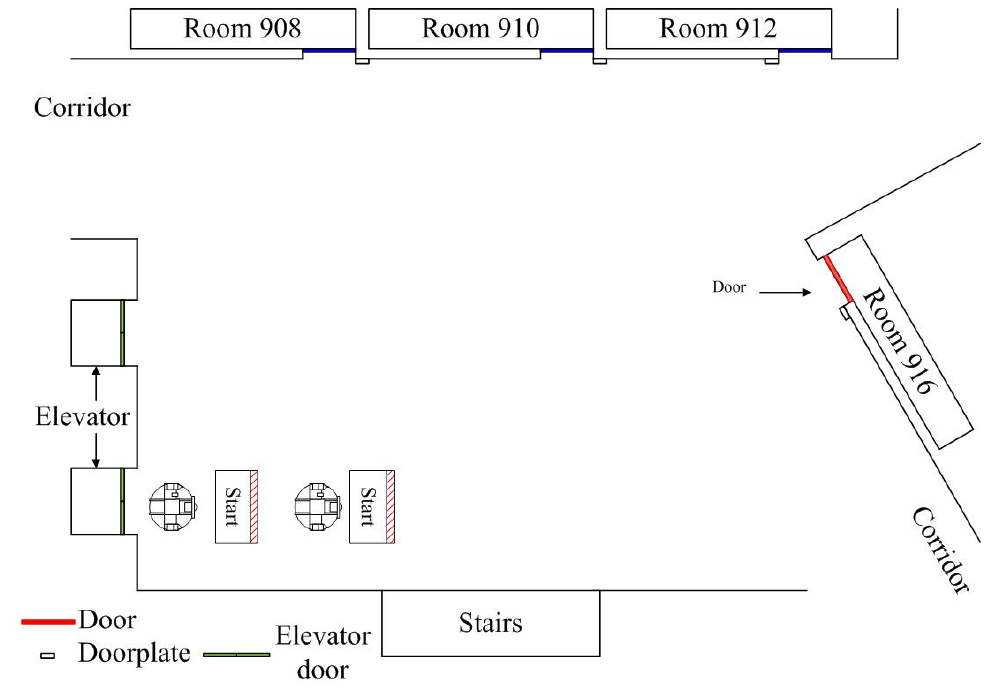
Figure 17. Initial setup and experimental environment.